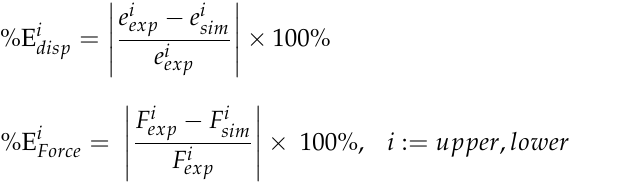
) and the bearing force (%E i Force ). disp